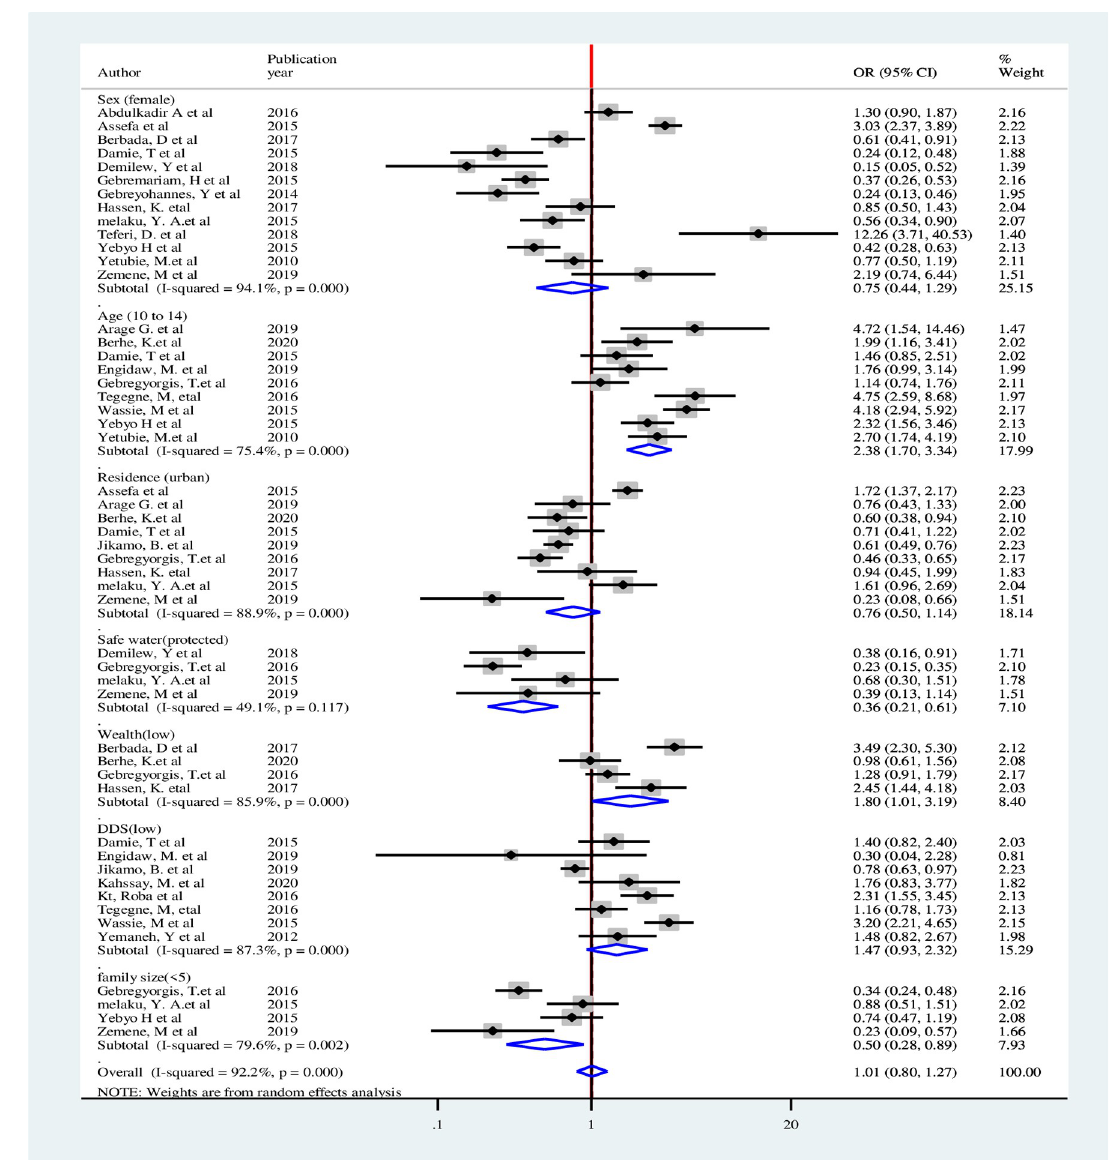
Fig 15. Pooled Odds Ratio of factors associated with thinness among adolescent in